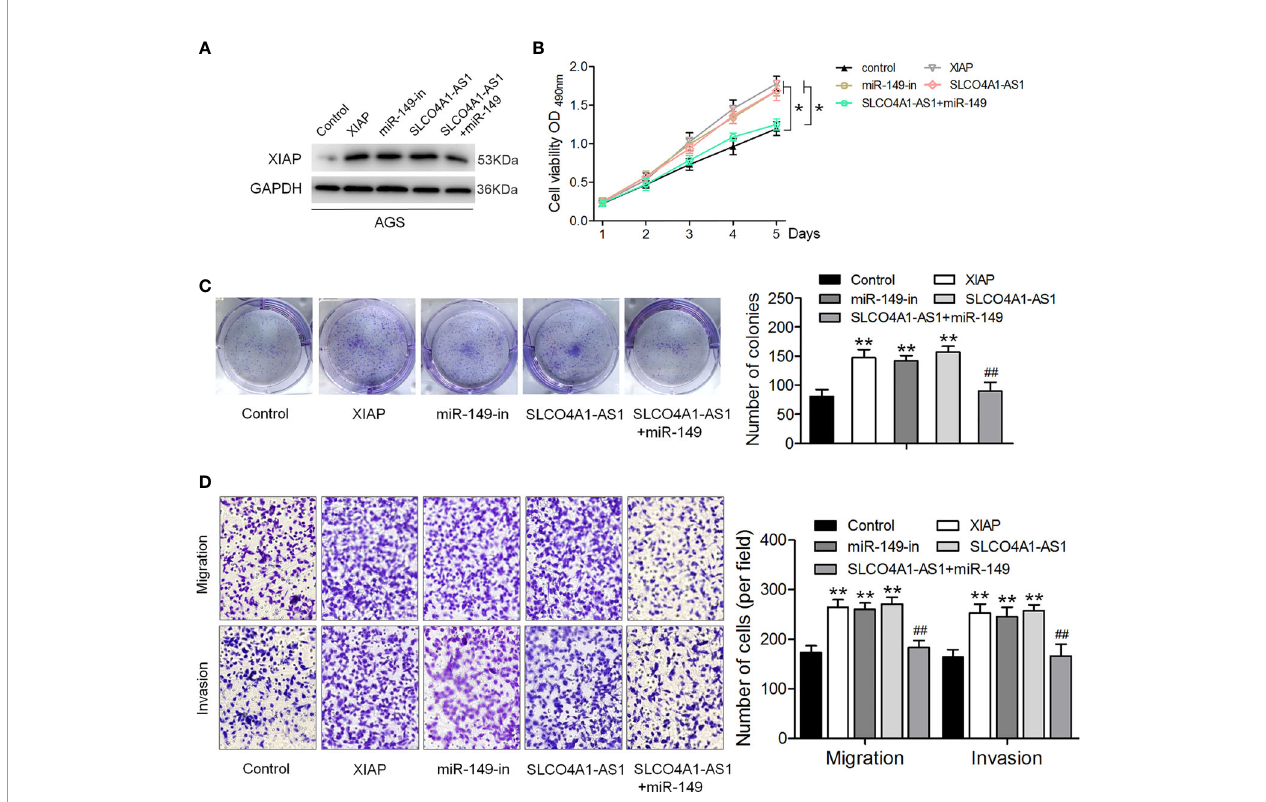
FIGURE 5 | SLCO4A1-AS1 accelerates the migratory and invasive abilities of GC cells via the miR-149/XIAP axis. (A) Western blotting assay for determining XIAP protein expression in XIAP, miR-149 inhibitor, SLCO4A1-AS1, and SLCO4A1-AS1 plus miR-149 mimic transfected GC cells. (B) Cell proliferation was determined using CCK-8 assay. (C) Cell cloning capability was measured using colony formation assay. (D) Cell migratory and invasive abilities were measured using Transwell assays. * P < 0.05, ** P < 0.01 vs. control group. ## P < 0.01 vs. SLCO4A1-AS1